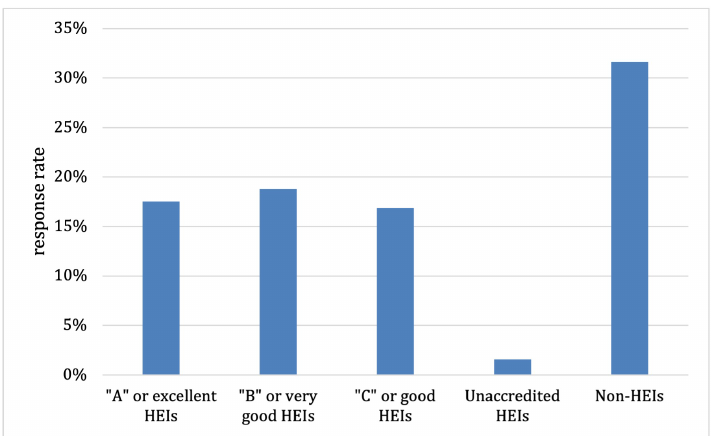
Figure 11. Response rate of the